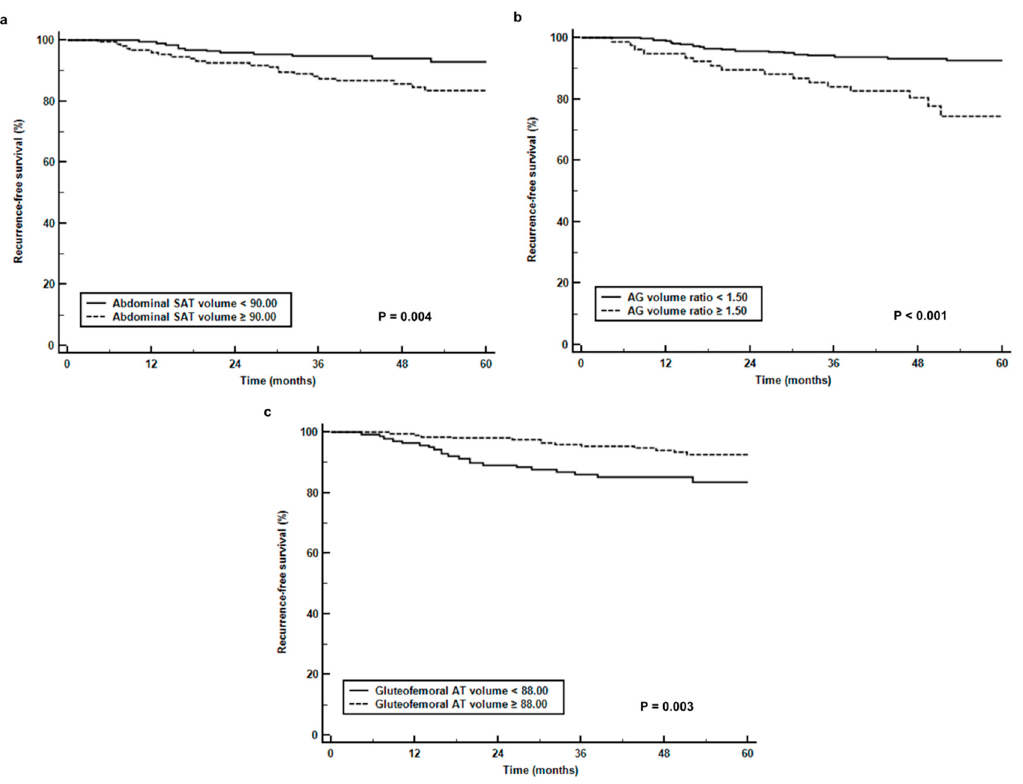
Figure 3. ( a ) Recurrence-free survival curves stratified by abdominal subcutaneous adipose tissue volume (abdominal SAT volume) ( b ), the ratio of abdomen-to-gluteofemoral adipose tissue volume (AG volume ratio), and ( c ) gluteofemoral adipose tissue volume (gluteofemoral AT volume). Table 4. Recurrence rates based on the combination of BMI and AG volume ratio.